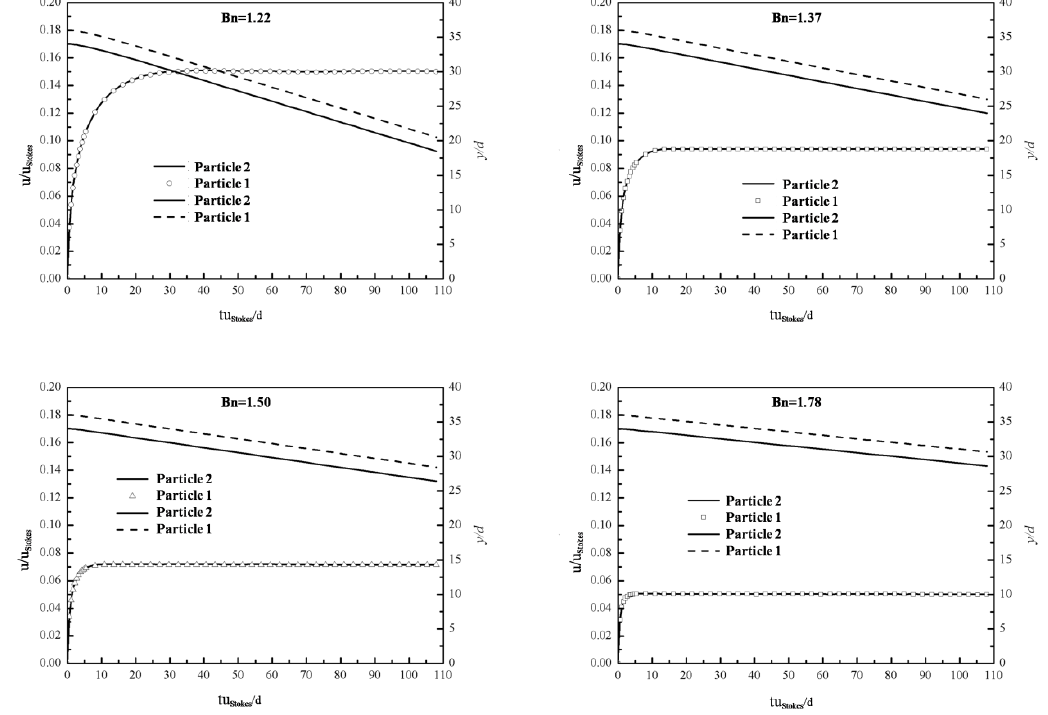
Figure 7. Velocities and positions of the two falling particles in Bingham fluid with various Bn s (1.22, 1.37, 1.50, and 1.78).